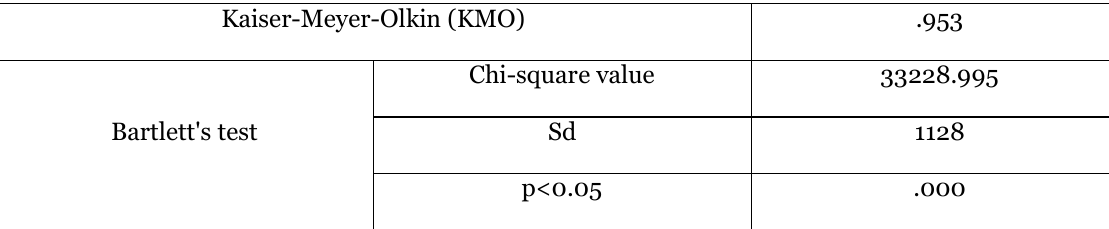
Assessing the Suitability of Data for the Exploratory Factor